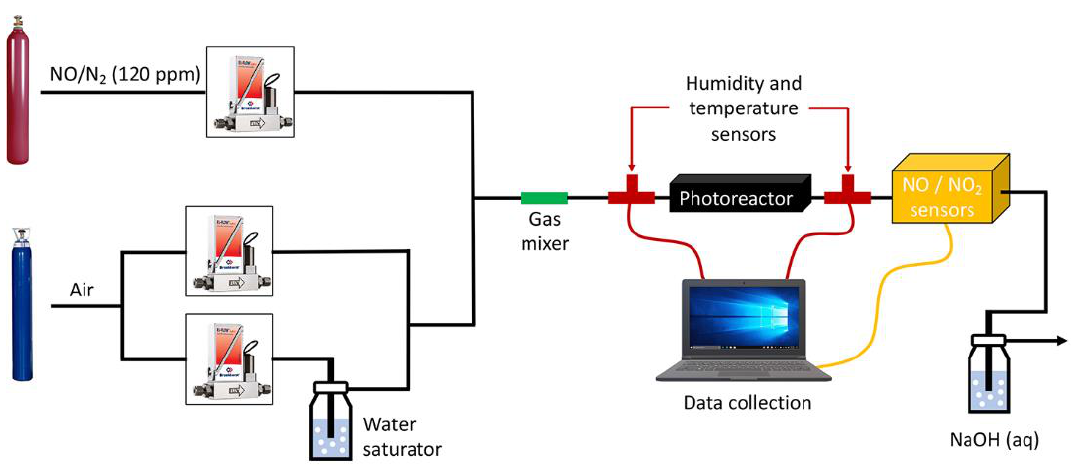
Figure 1. Schematic representation of the experimental setup.